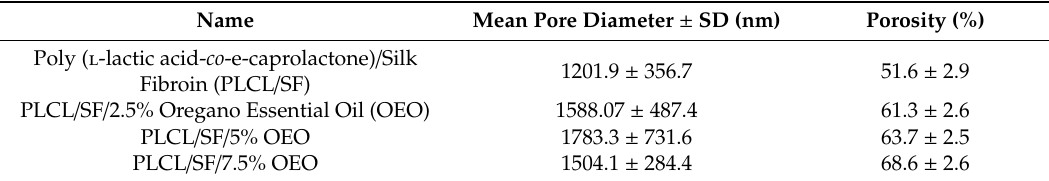
Table 1. Mean pore diameter and porosity of various Nanofibrous (NF) membranes with Standard deviation (SD) values.